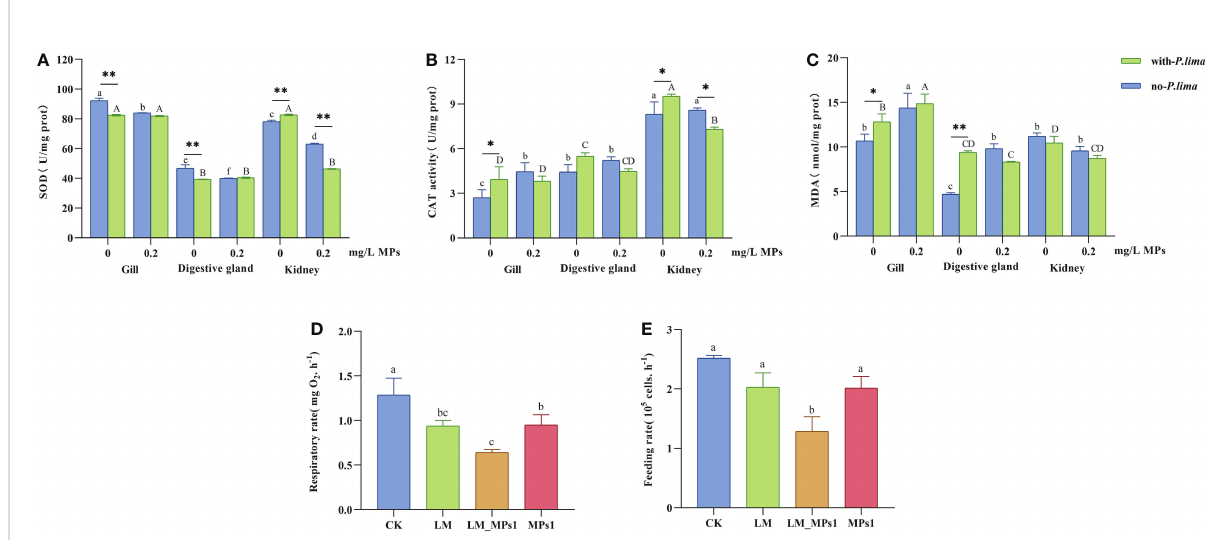
FIGURE 1 Physiology index change of M. coruscus exposure to MPs and P. lima . (A) SOD activities, (B) CAT activities, (C) MDA content, (D) respiration rate, (E) feeding rate. Different letters indicate signi fi cant differences between different tissues in different concentrations of MPs in the presence or absence of P. lima in (A, B, C) ( p < 0.05), and different letters indicate signi fi cant differences in different groups in (D, E) ( p < 0.05), and asterisks indicate signi fi cant differences between the presence and absence of P. lima within each fi xed concentration of MPs between different tissues. (* p < 0.05; ** p <